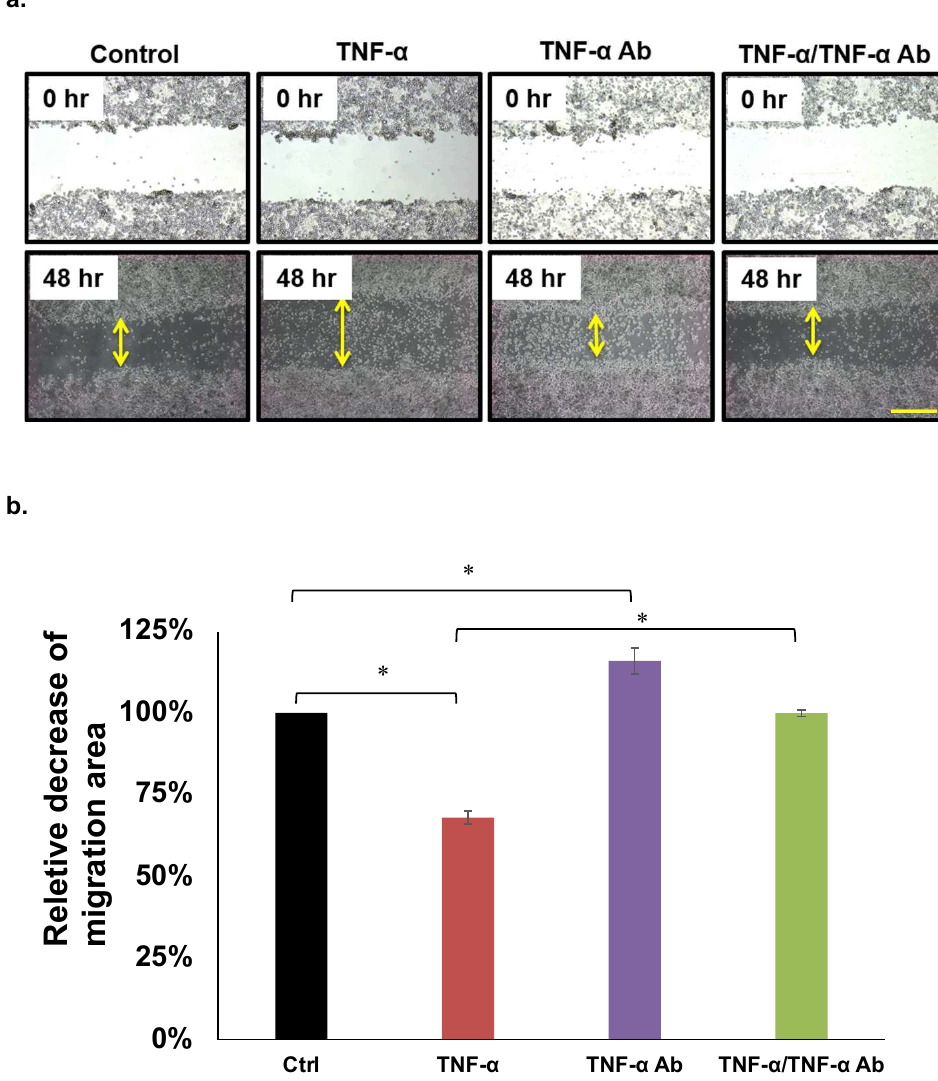
Figure 3. Migration assays. ( a , b ) Representative COLO205 data. Concentrations of TNF-α and human anti TNF-α Ab: 50 ng/mL and 2 µg/mL, respectively. * p < 0.05. Scale bar represents 200 µm.